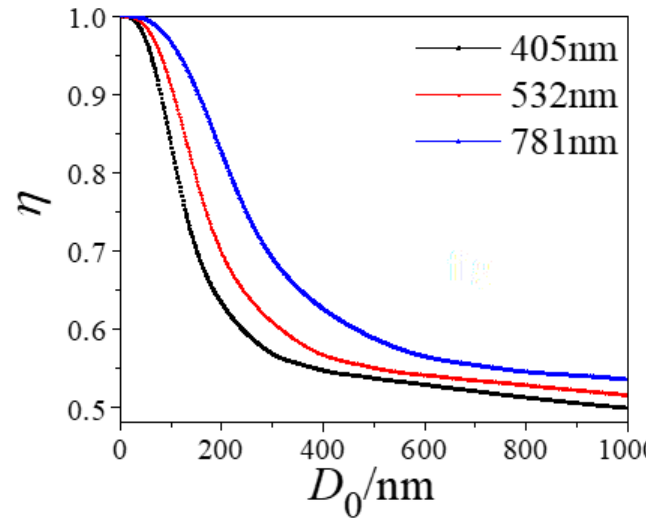
Figure 6. Changes in absorption proportion η with core diameter D 0 for uncoated soot particles under various incident wavelengths.